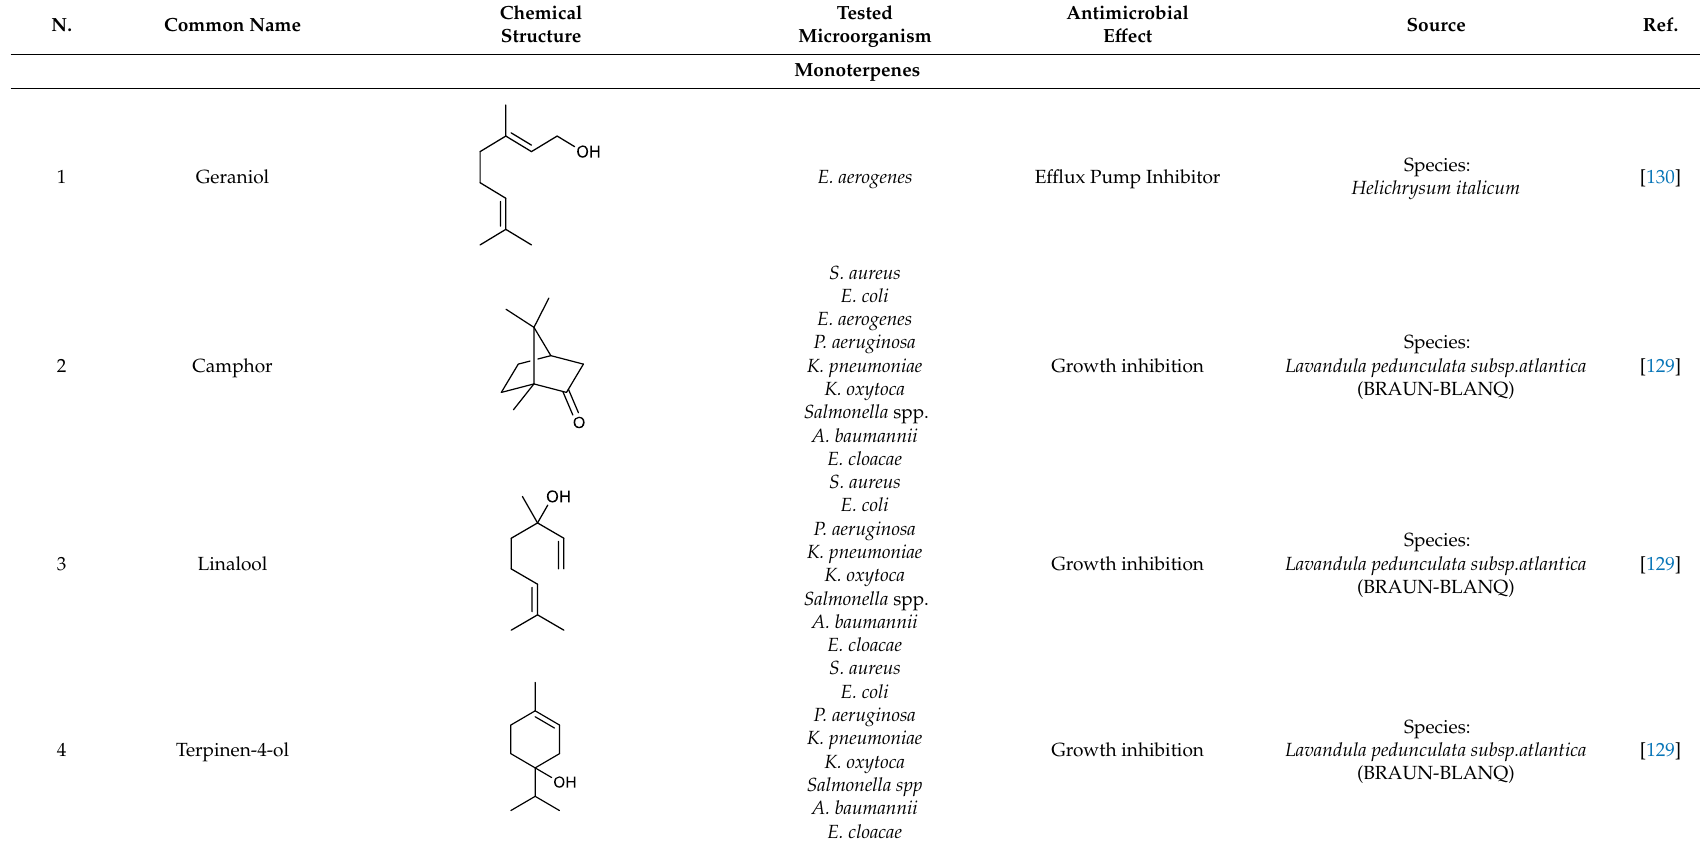
Table 3. Summary of triterpenes with antimicrobial activity against resistant strains.